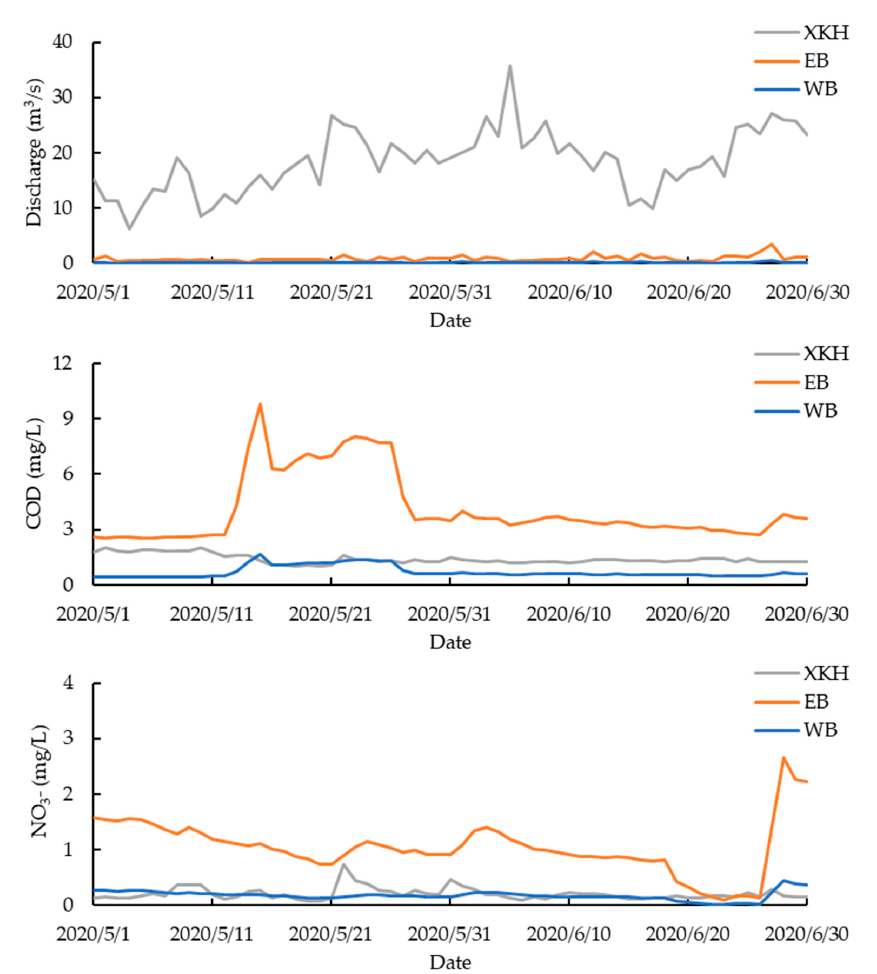
Figure 5. Discharges and inputs of COD and NO 3 − from the west branch (WB) and the east branch (EB) of the Tanghe River and Xinkaihe River.